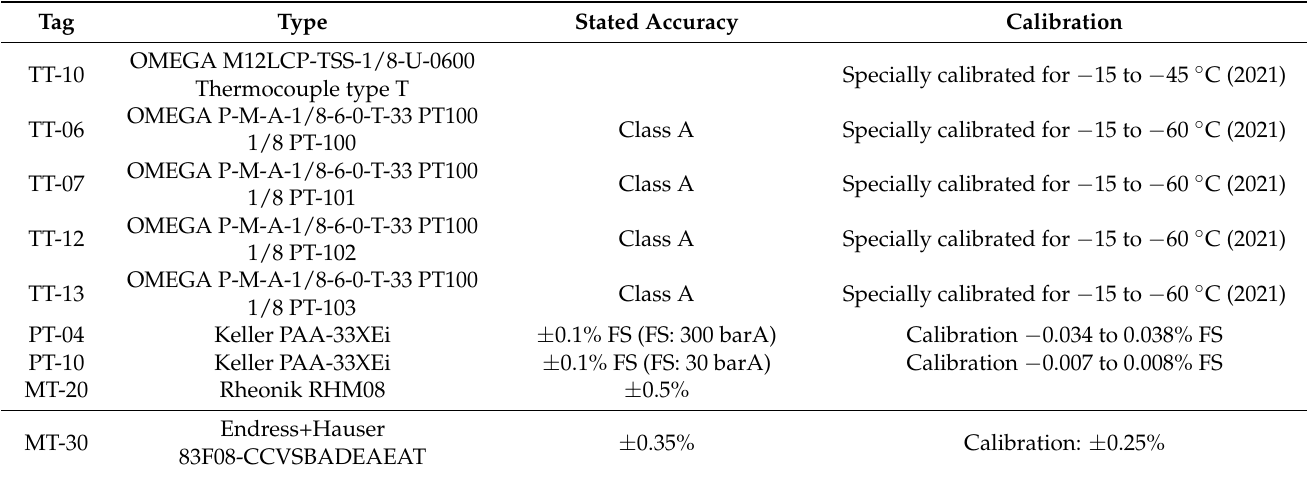
Table 2. Uncertainties for selected